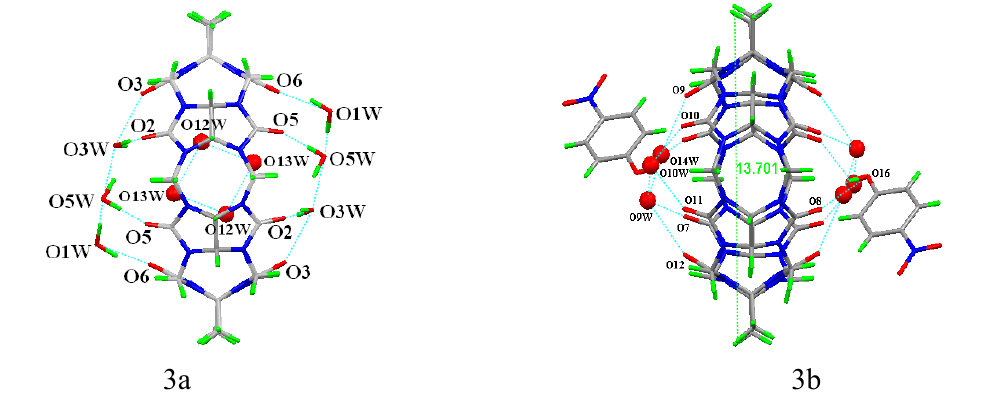
Figure 3 . The molecular encapsulate based on the Q1 (a), and the the molecular encapsulate shell based on the Q2 (b).